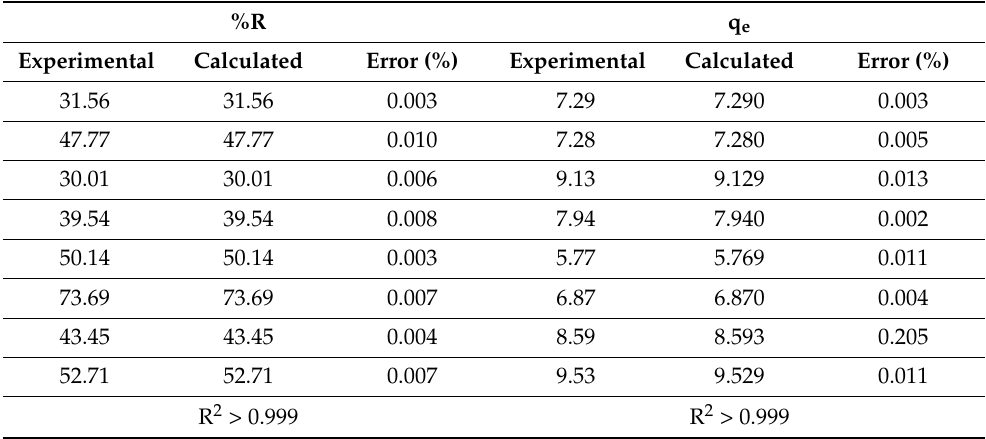
Table 6. Experimental and calculated values and relative error of the model for the metal retained percentage ( %R ) and biosorption capacity ( q e